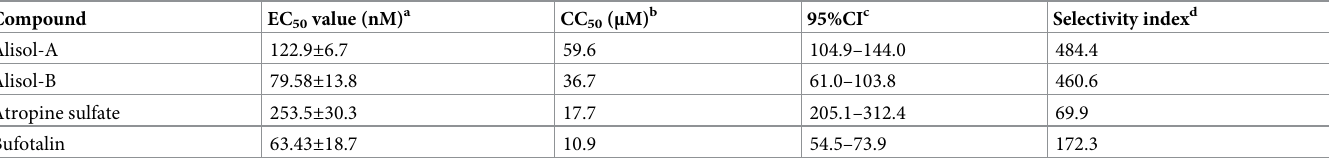
Table 2. Biological activity of hit compounds evaluated against the in vitro growth of C . parvum . Compound